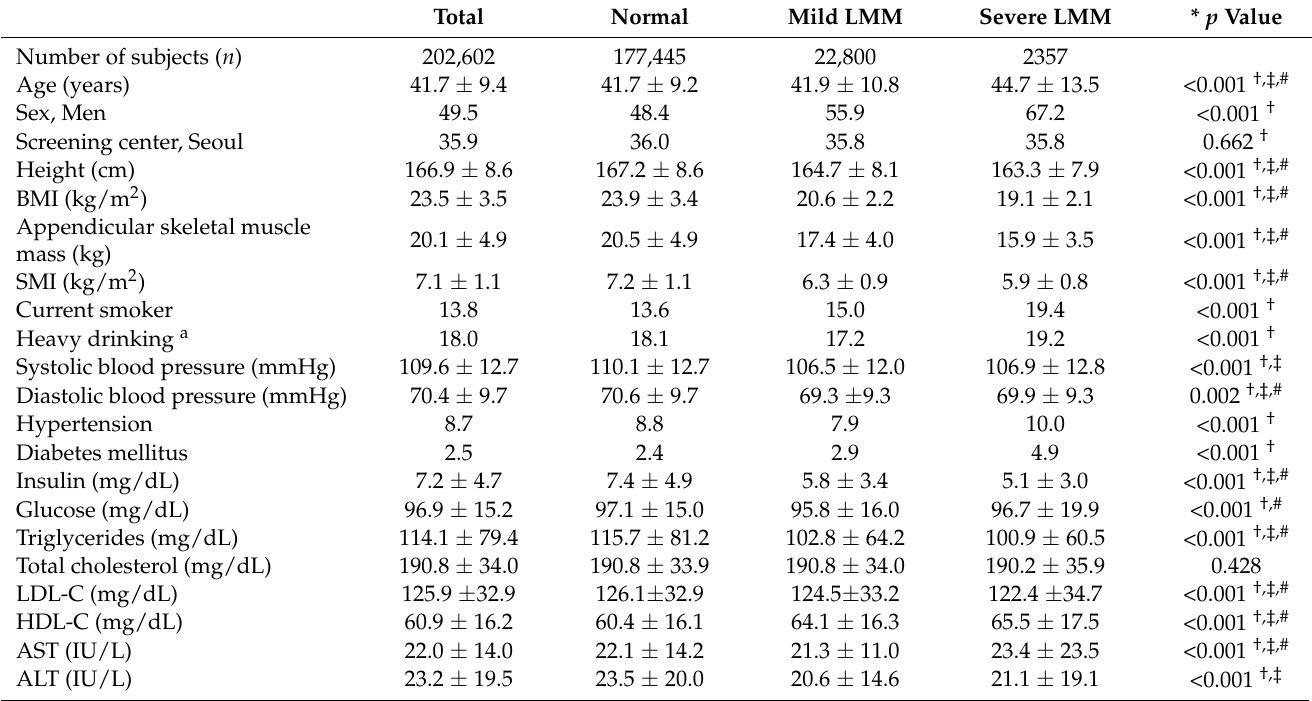
Table 1. Baseline characteristics of study subjects classified by skeletal muscle